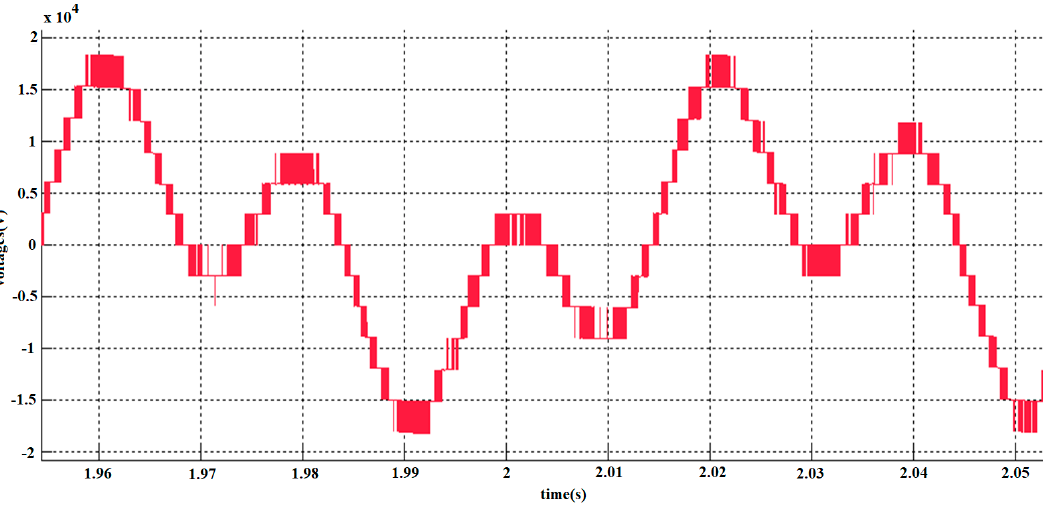
Figure 19. PWM waveform of hexverter voltages.